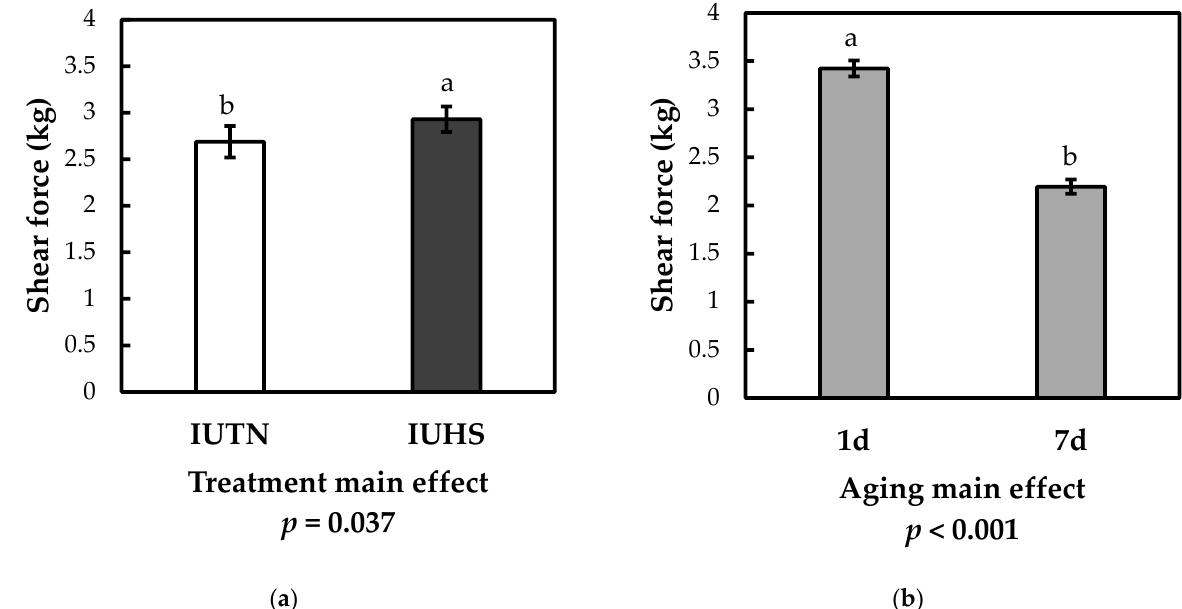
Figure 1. Main effects of in utero heat stress (IUHS) and in utero thermoneutral (IUTN) treatment ( a ) and postmortem aging duration ( b ) on shear force values of pork loin muscle. Different letters a, b indicate least square means different at p < 0.05. The two-way interaction was not significant ( p = 0.160).